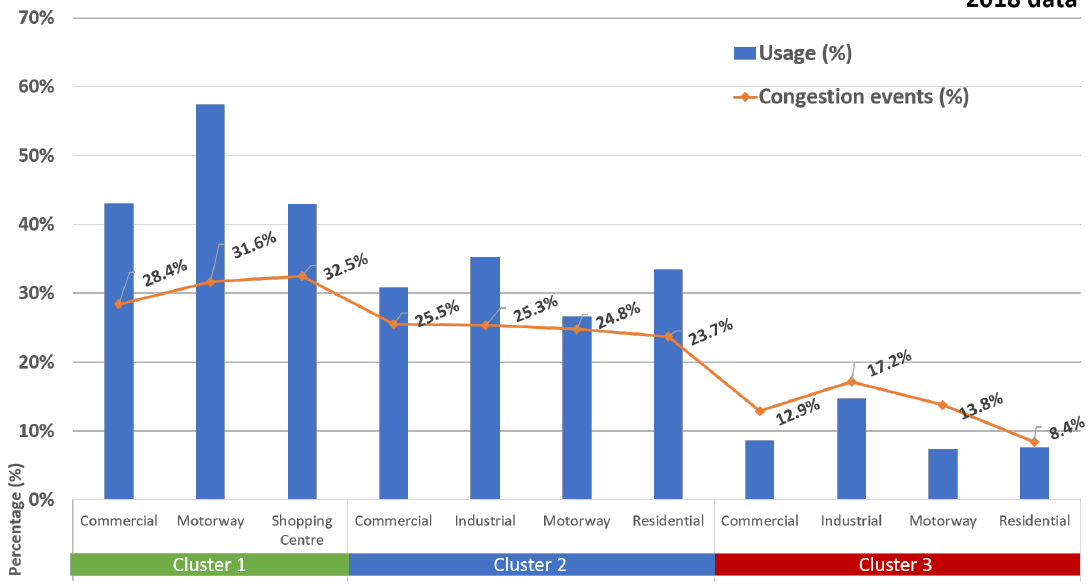
Figure 20. Summary graph of congestion event over 2017-2019 Figure 18. Network infrastructure usage and congestion events in percentage for year 2018